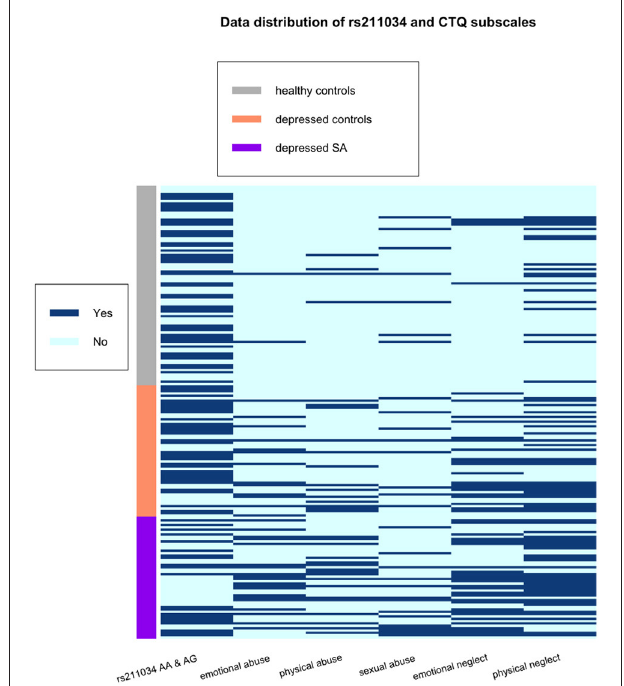
FIGURE 2 | Data distribution of the SNP rs211034 and five CTQ subscales, grouped by patients’ suicide attempt status.